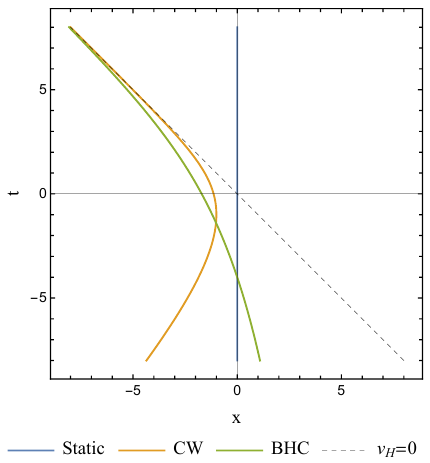
Figure 1 . The various mirror trajectories considered in this paper are shown here, with (cid:20) = 1 = 2 for CW and (cid:20) = 1 = 4 and v H = 0 for